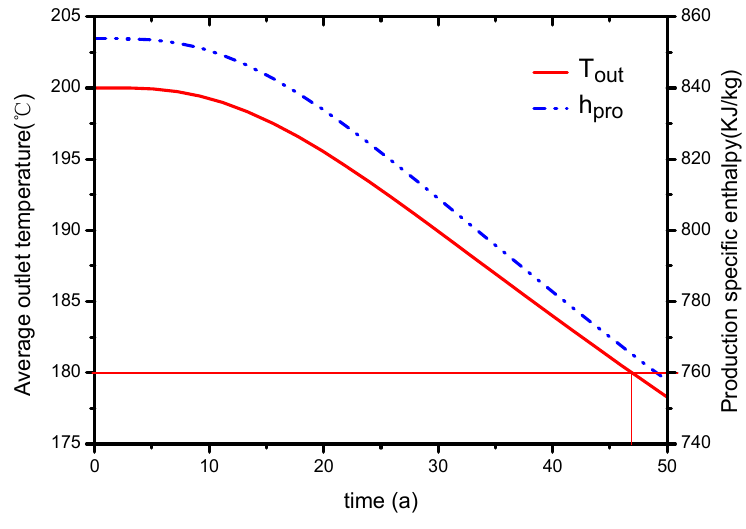
Figure 4. Evolution of out T and out h during the 50 year period.